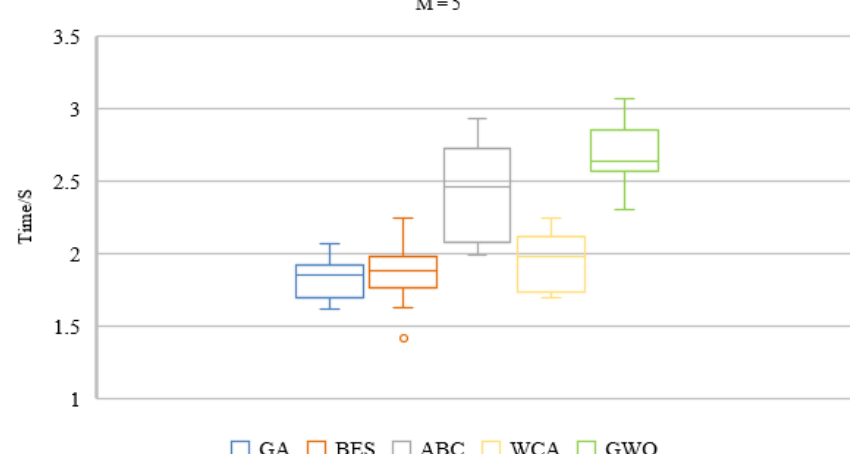
Figure 14. Running time box plot when the population is 5.